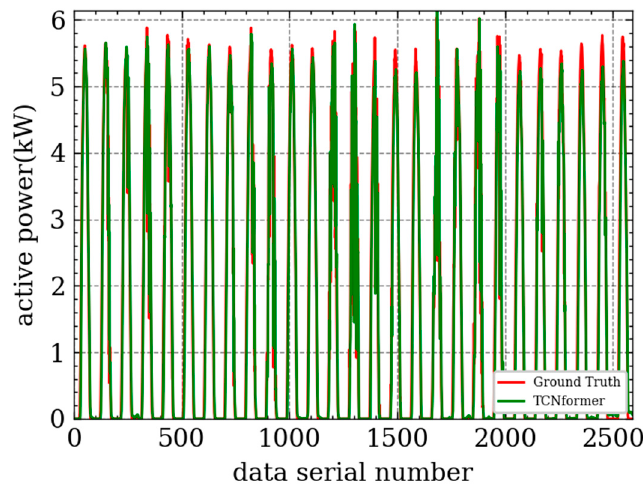
Figure 10. Results of the TCNformer model.